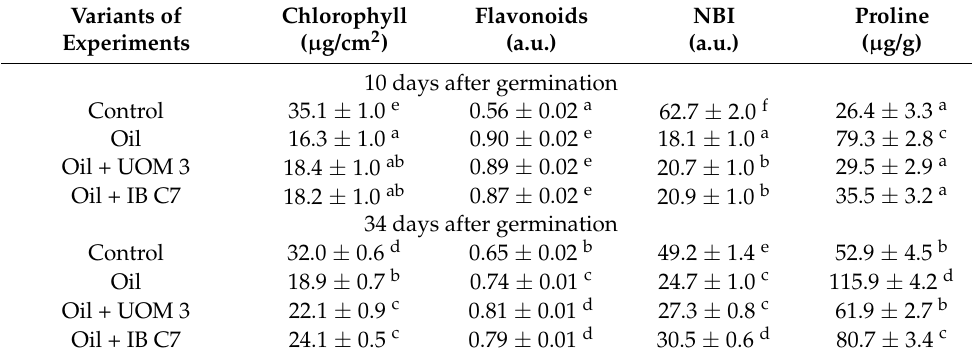
Table 4. Biochemical indicators of barley